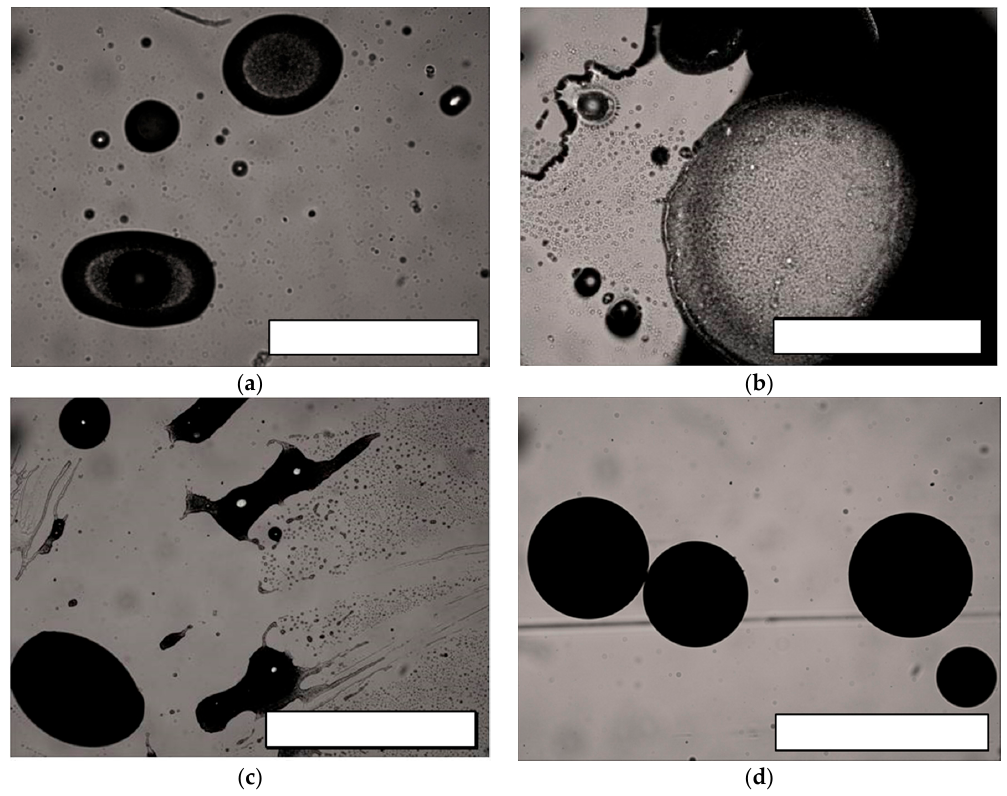
Figure 2. Micrographies acquired under optical transmission microscopes of aliquots of the oil/water emulsion containing CPG (10 wt. %)/PDLA in the oil phase and withdrawn at ( a ) 5 min, ( b ) 15 min, ( c ) 25 min and ( d ) 35 min after the dispersion onset. Scale bar is 1000 μ m.